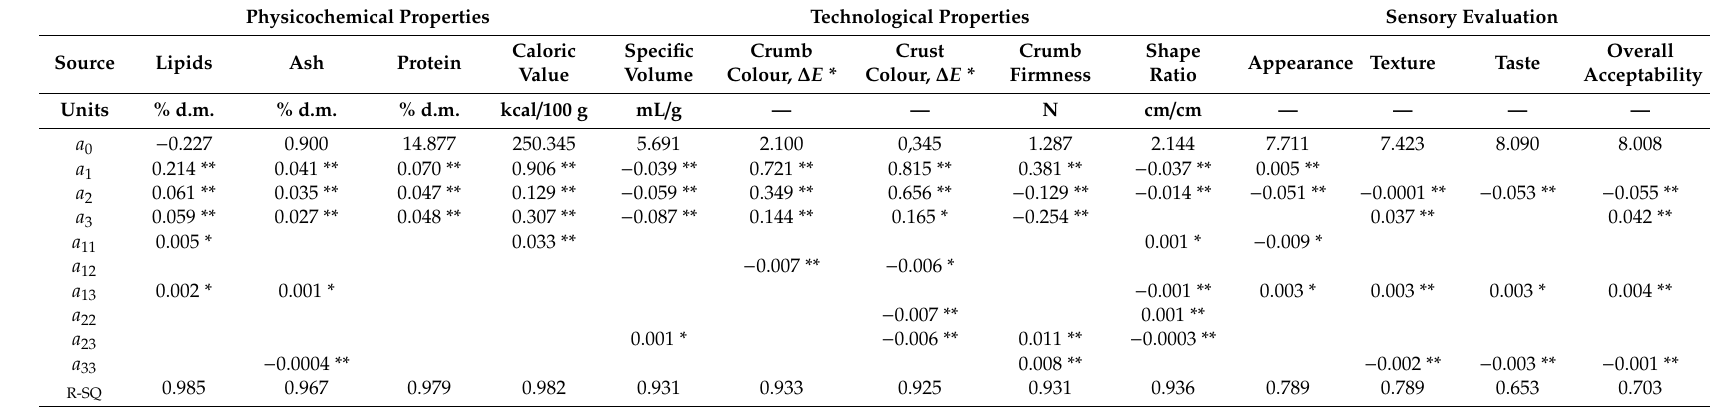
Table 3. Factorial design coe ffi cients of nutritional, technological, and sensory properties of